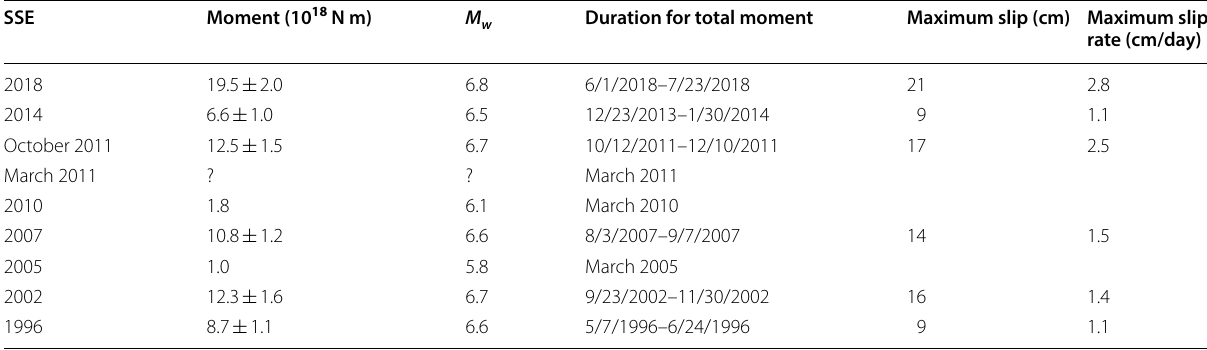
Table 1 Moment, maximum slip and maximum slip rate of Boso SSEs. Data of the 2005 and 2010 events are